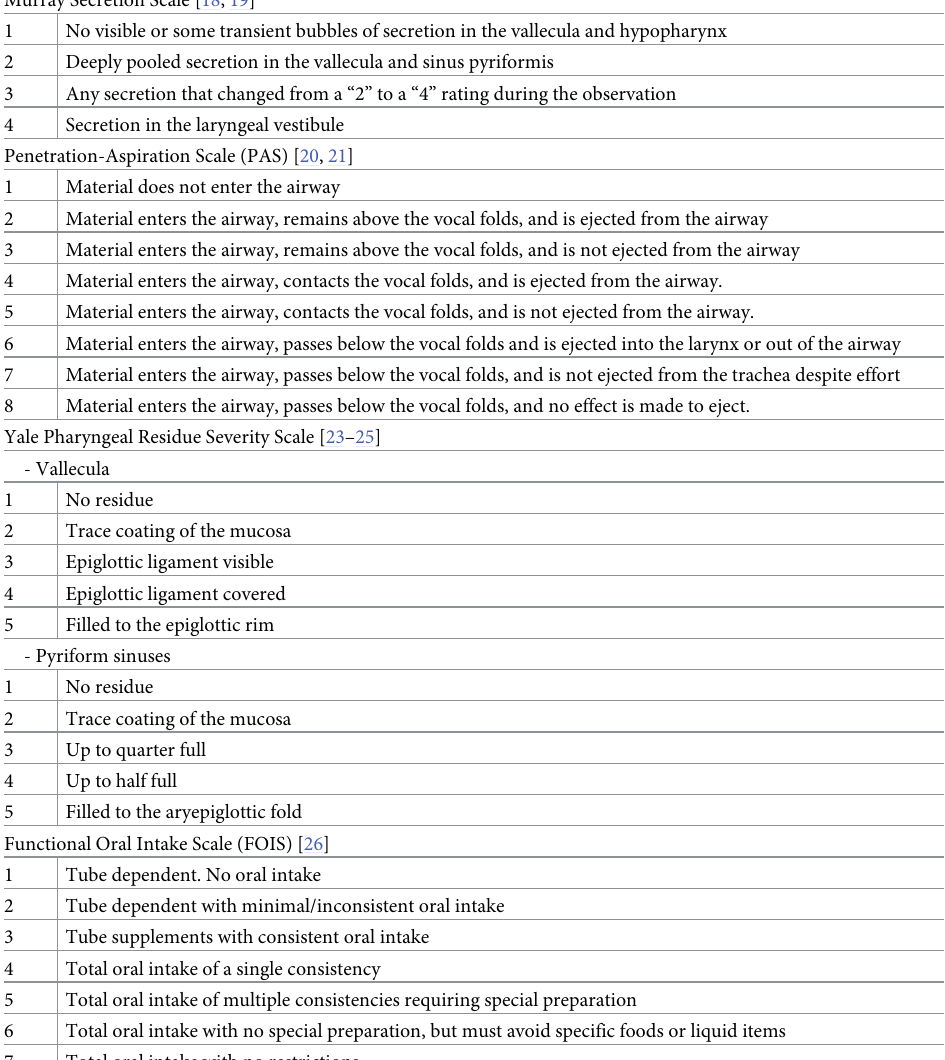
Table 1. Rating scales for analysis of FEES